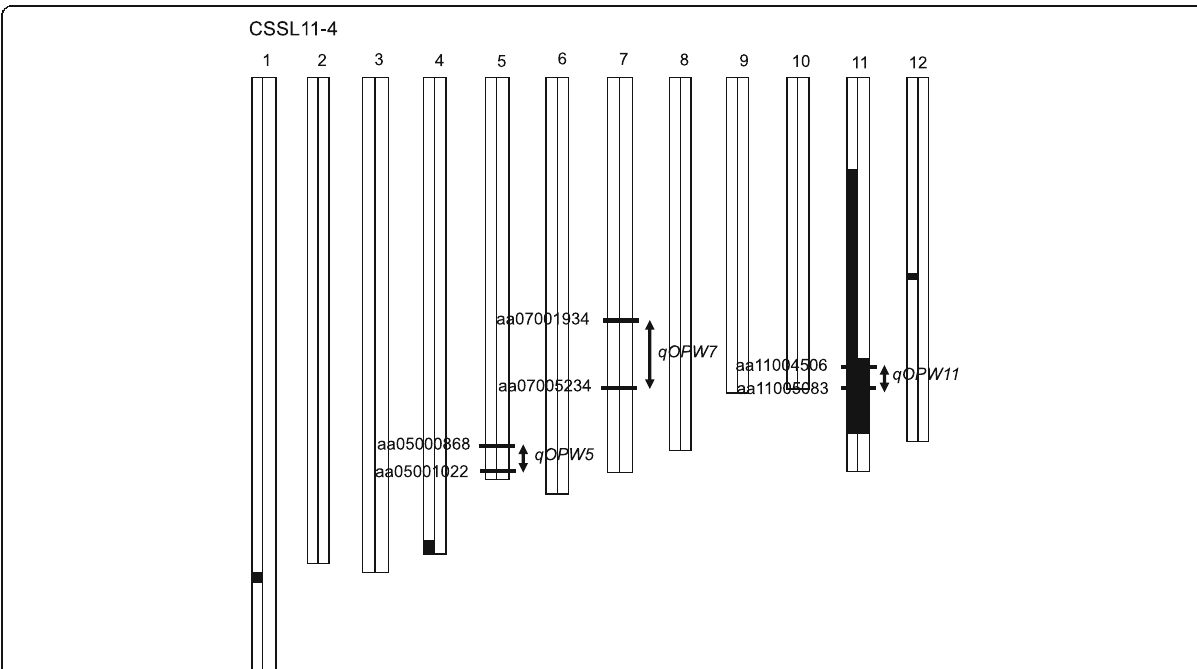
Fig. 2 Graphical genotype of CSSL11 – 4 in 2015. Black and white blocks represent the genomic segments of Yamadanishiki and Koshihikari, respectively. The single nucleotide polymorphism markers show the interval markers around the detected QTLs for one panicle